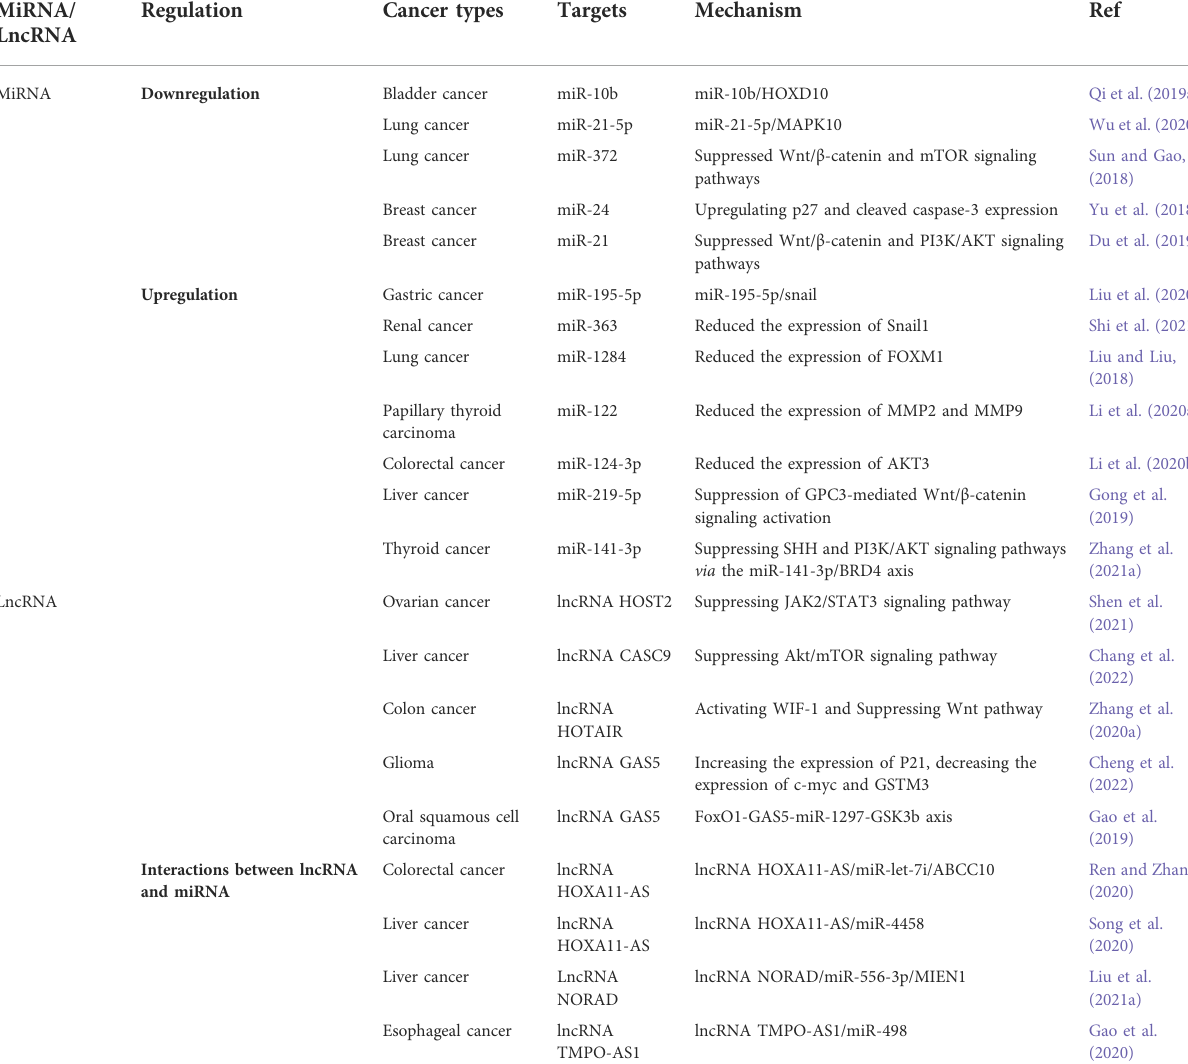
TABLE 1 Propofol inhibits tumors by regulating